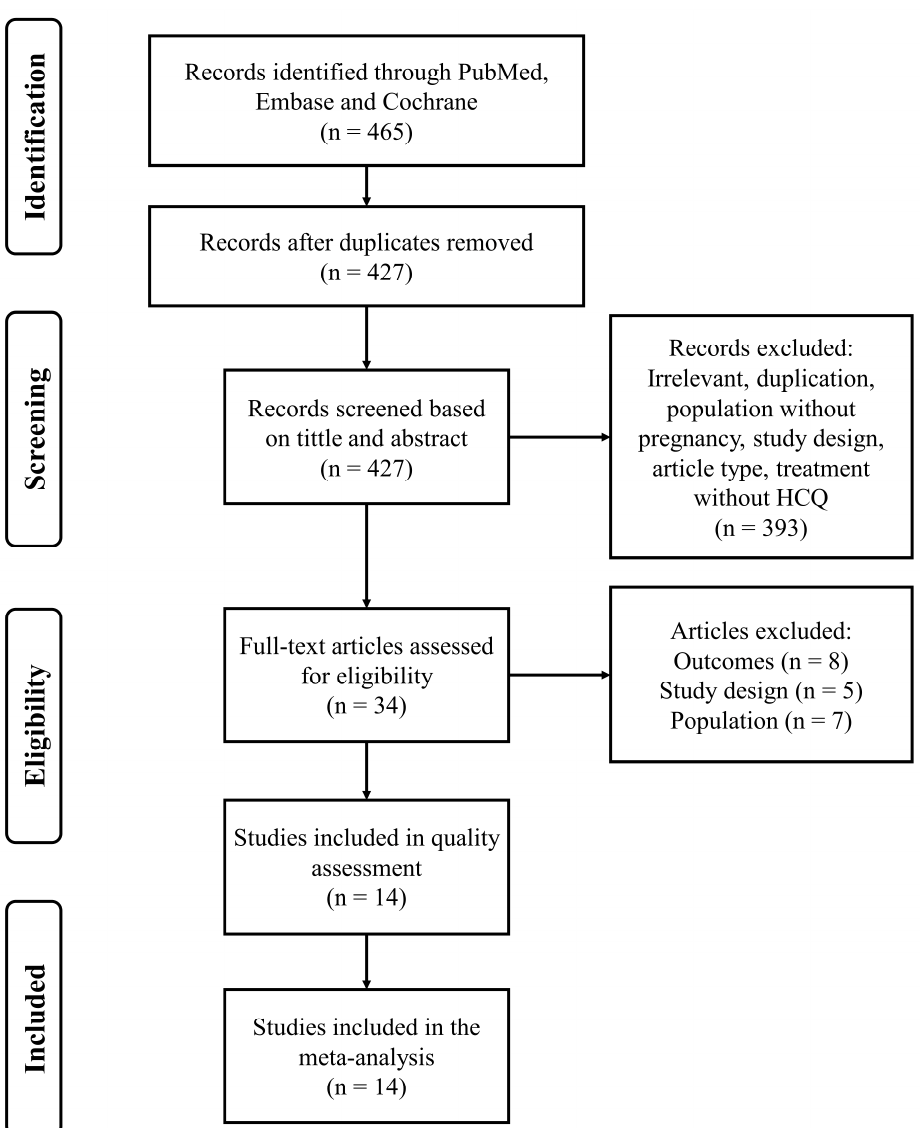
Figure 1. PRISMA flow chart.